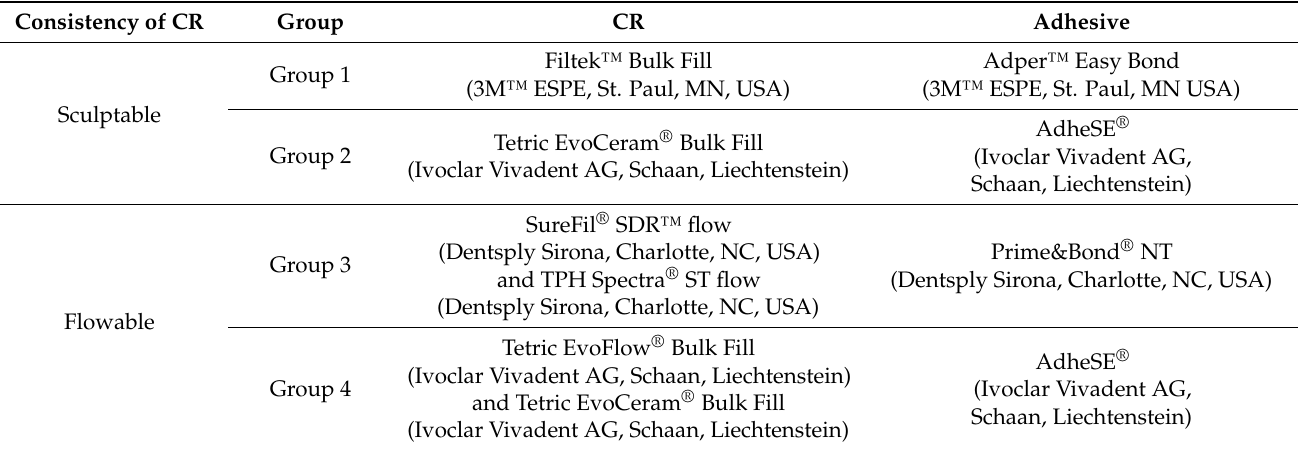
Table 1. Materials used for the restorations of the extracted human